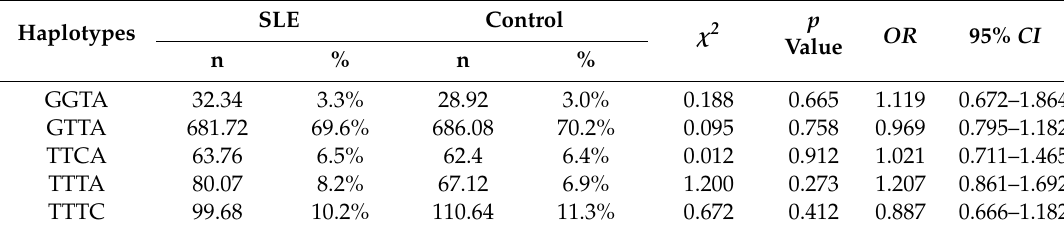
Table 5. Haplotype analysis results among four SNPs in IL-12A